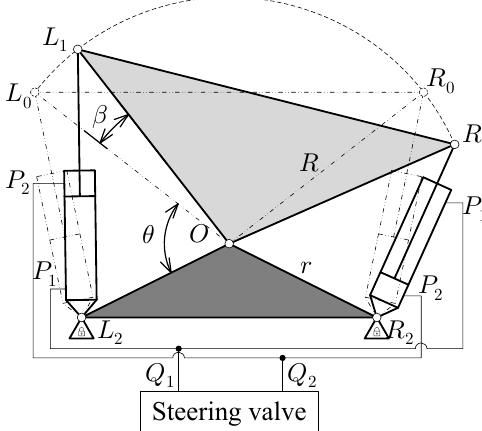
Figure 3. Hydraulic steering system